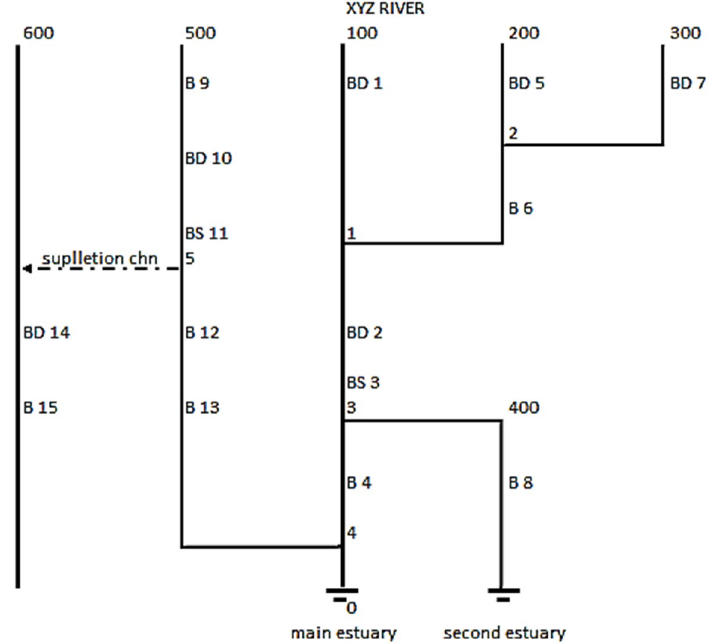
Figure 9. Synthetic river scheme.